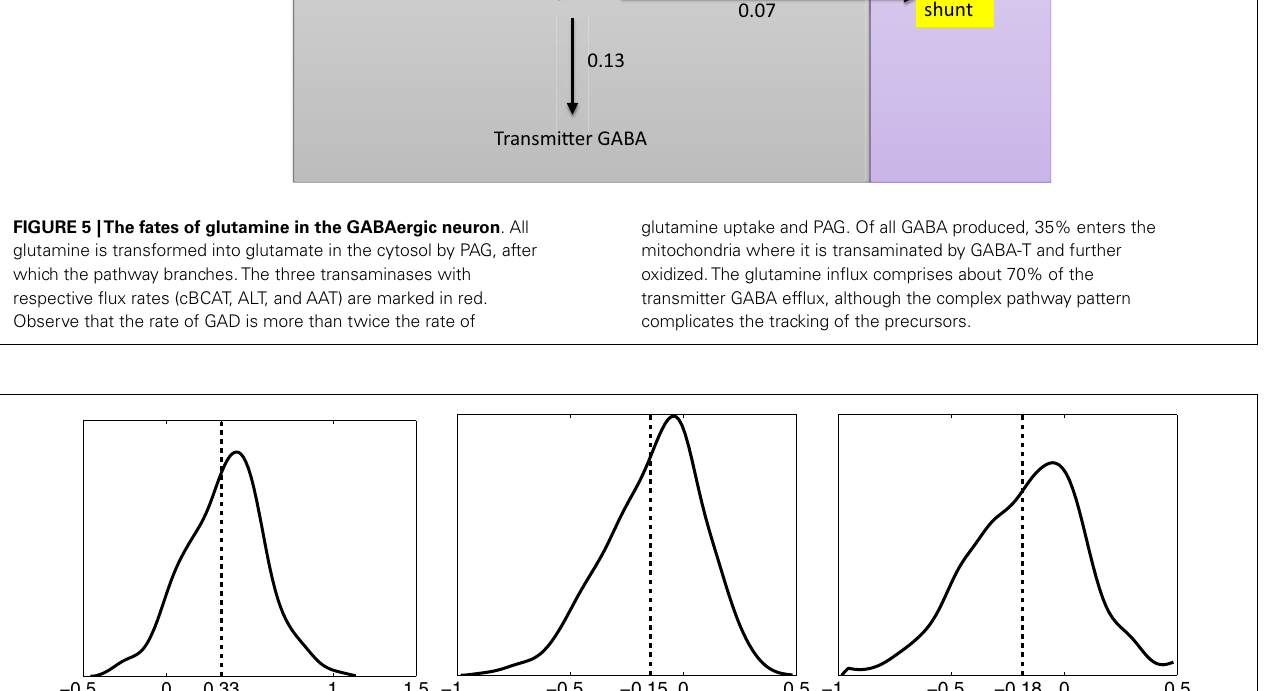
FIGURE 6 |The smoothed histograms of the GDH fluxes in each of the three cell types, calculated from the sample of 200,000 realizations .The sample mean in each cell is indicated by the vertical line. Observe that the sum of the mean activities in the neurons equal the negative of the astrocytic